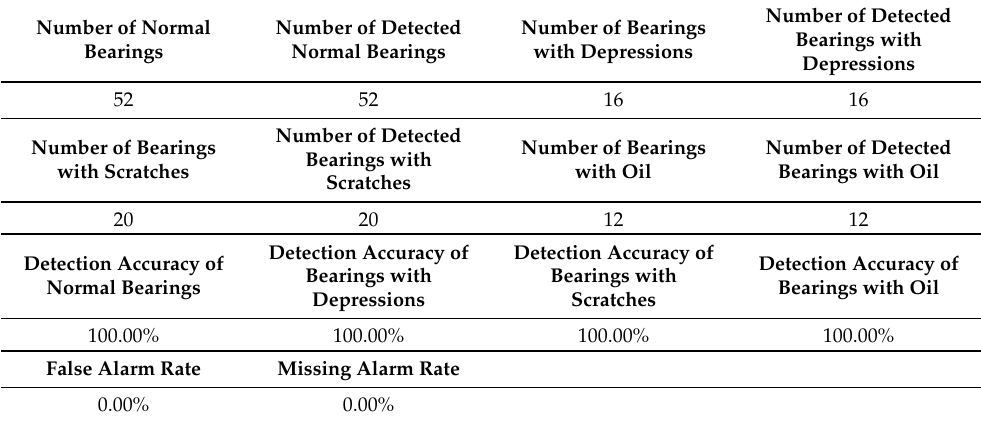
Table 4. Detection results of depressions, scratches and oil in non-character regions.